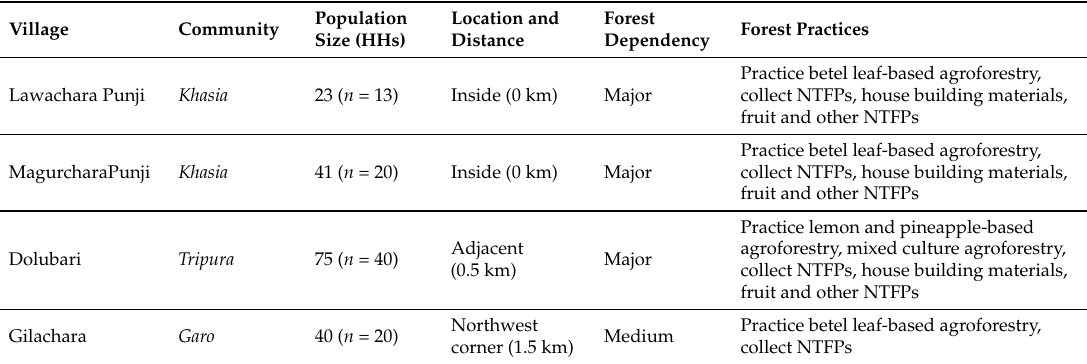
Table 1. Sample distribution over the surveyed